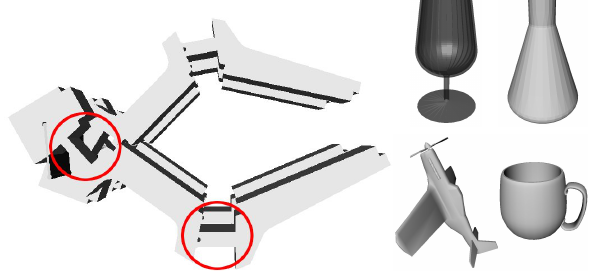
Fig. 2. MODEL OF THE HARVARD HAND AND OBJECT Figure 2. Model of the harvard hand and object models used for MODELS USED FOR GRASP POOL GENERATION. grasp pool